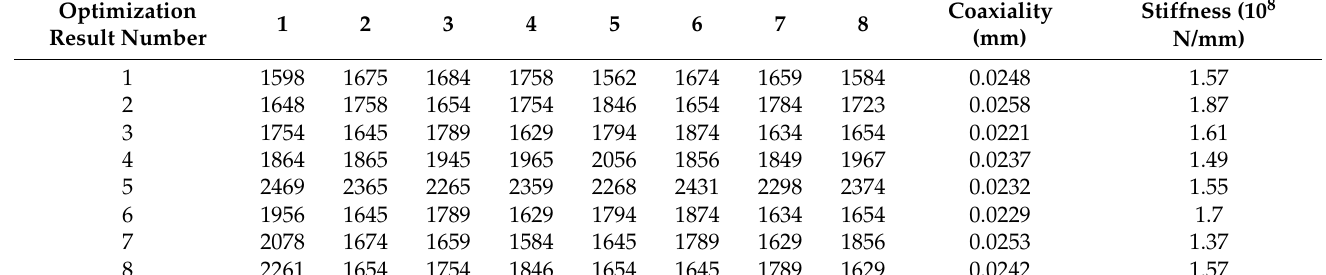
Table 7. Optimization results of bolt tightening process (unit: N).